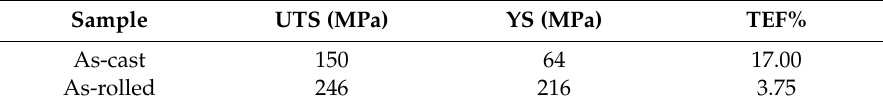
Table 2. The mechanical properties of the Mg-2Y-0.6Nd-0.6Zr